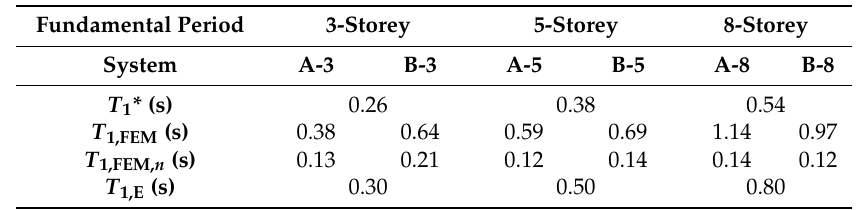
Table 3. Fundamental periods.